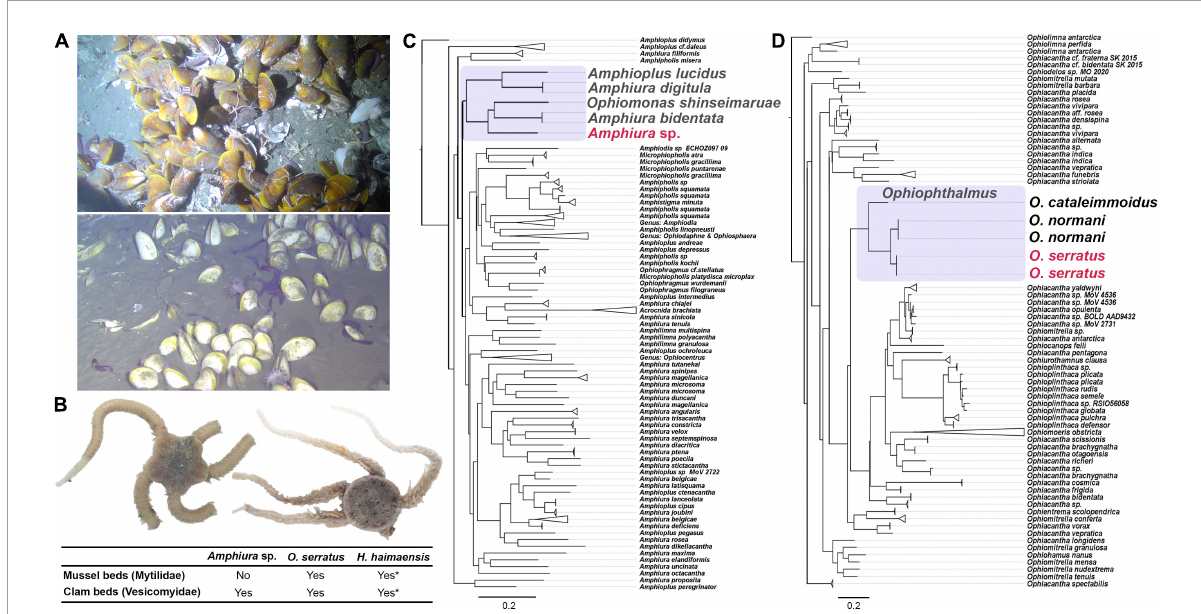
FIGURE1 Description of two brittle stars collected from Haima cold seep. (A) Two dominant ecosystems of the Haima cold seep: Gigantidas haimaensis mussel bed (top) and Calyptogena marissinica clam bed (bottom); (B) sample of brittle stars Amphiura sp. (left) and Ophiophthalmus serratus (right) and their occupied ecosystem(s); stars means refer to Li’s study (Li et al., 2021); (C) phylogenetic relationship using maximum likelihood analysis of COX1 sequences of Amphiuridae, our sample was sister of Amphiura bidentata and Ophiomonas shinseimaruae , but the identity is as low as 81.5 and 80.9%, respectively; (D) phylogenetic relationship by ML analysis of Ophiacanthidae COX1 sequences. The nucleotide similarity between O. serratus and O. normani is ∼ 92%.